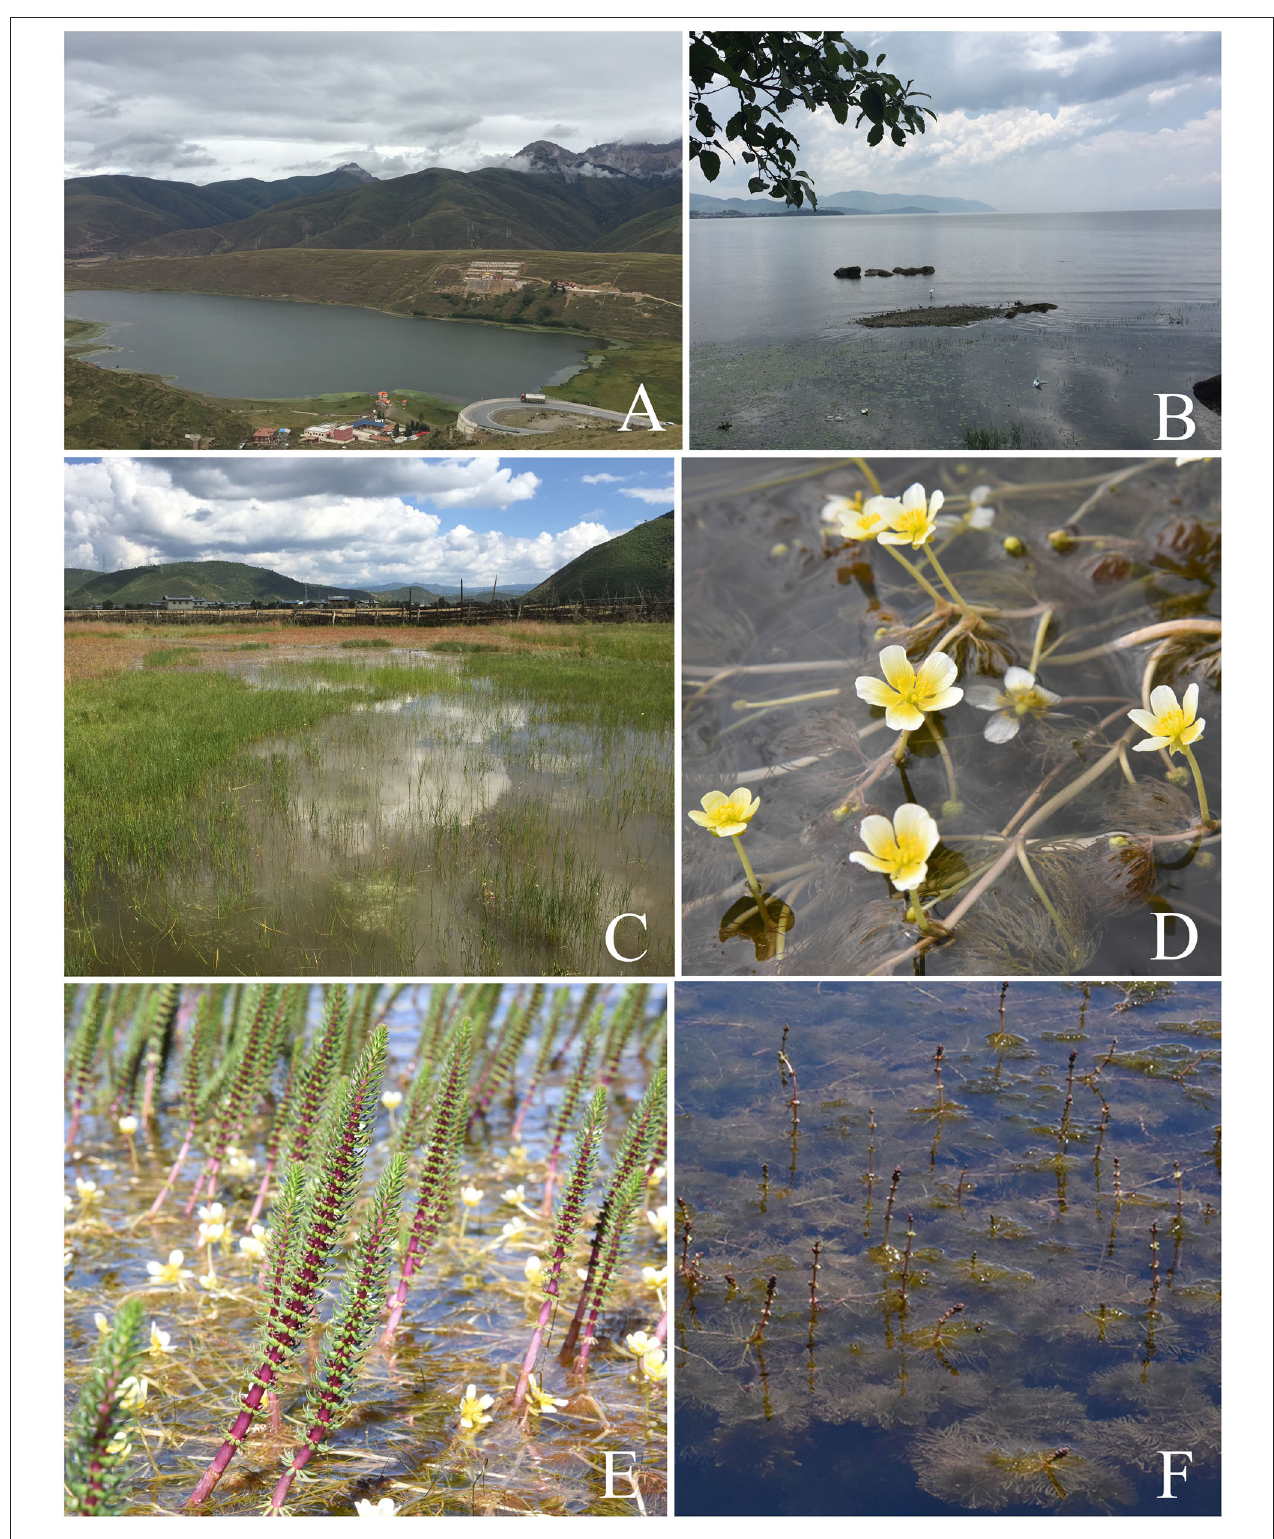
FIGURE 2 | Representative sampling sites and aquatic plants. (A) The sampling site Kashahu in Sichuan Province. (B) The sampling site Erhai in Yunnan Province. (C) The sampling site Xianggelila in Yunnan Province. (D) The aquatic plant Batrachium bungei . (E) The aquatic plant Hippuris vulgaris . (F) The aquatic plant Myriophyllum spicatum